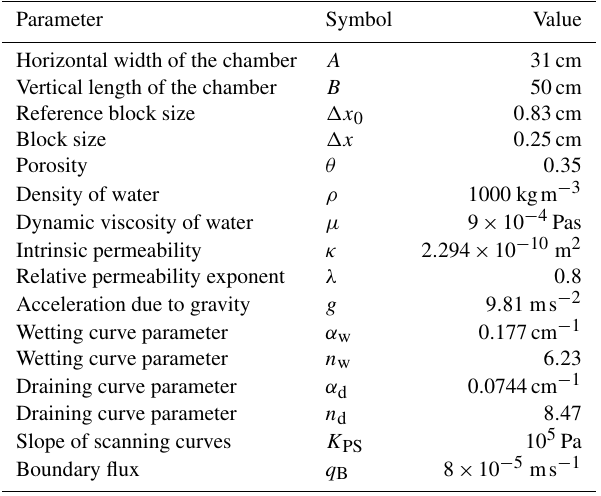
Table 2. The width of the moisture profiles for different values of (cid:49)x 0 . Moisture profile width Reference block size (cid:49)x 0